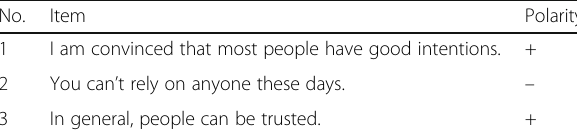
Table 2 Items of the English-language adaptation of KUSIV3 No.